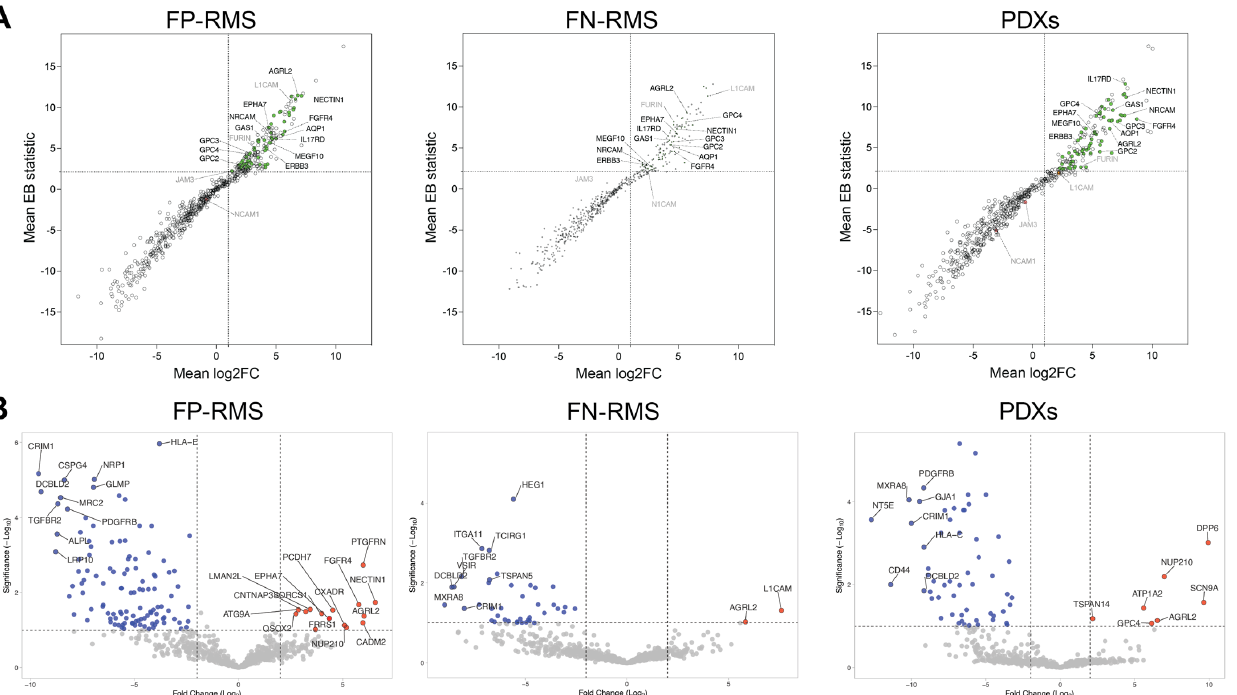
Figure 4. AGRL2 is significantly upregulated in FP-RMS, FN-RMS cell lines, and RMS PDXs. Results for the 699 proteins of interest (List C) using the imputed iTop3 intensities are shown for each set of cells. Two statistical analyses were used: ( A ) Cell-to-control differential expression. Shown here are the average log 2 fold changes between each cell of the set and MRC-5 and myoblasts versus the average of the corresponding moderated t-statistics of the comparisons. The proteins for which the moderated t-statistics were above 2.132 (95th percentile of the corresponding Student’s distribution) in all three sets of cells are highlighted in green, with some of the proteins present in the Top100 labeled. ( B ) Linear mixed model (LMM) was used as a statistical evaluation of the protein abundances detected in all the distinct groups (FP-RMS, FN-RMS, and PDXs) versus the controls. A threshold of signi fi cance ( − log 10 ) ≥ 1.3 and|log 2 FC| ≥ 1 was set to plot the statistically significant proteins in volcano plots. AGRL2 is the only protein significantly upregulated in all three RMS groups with this analysis.